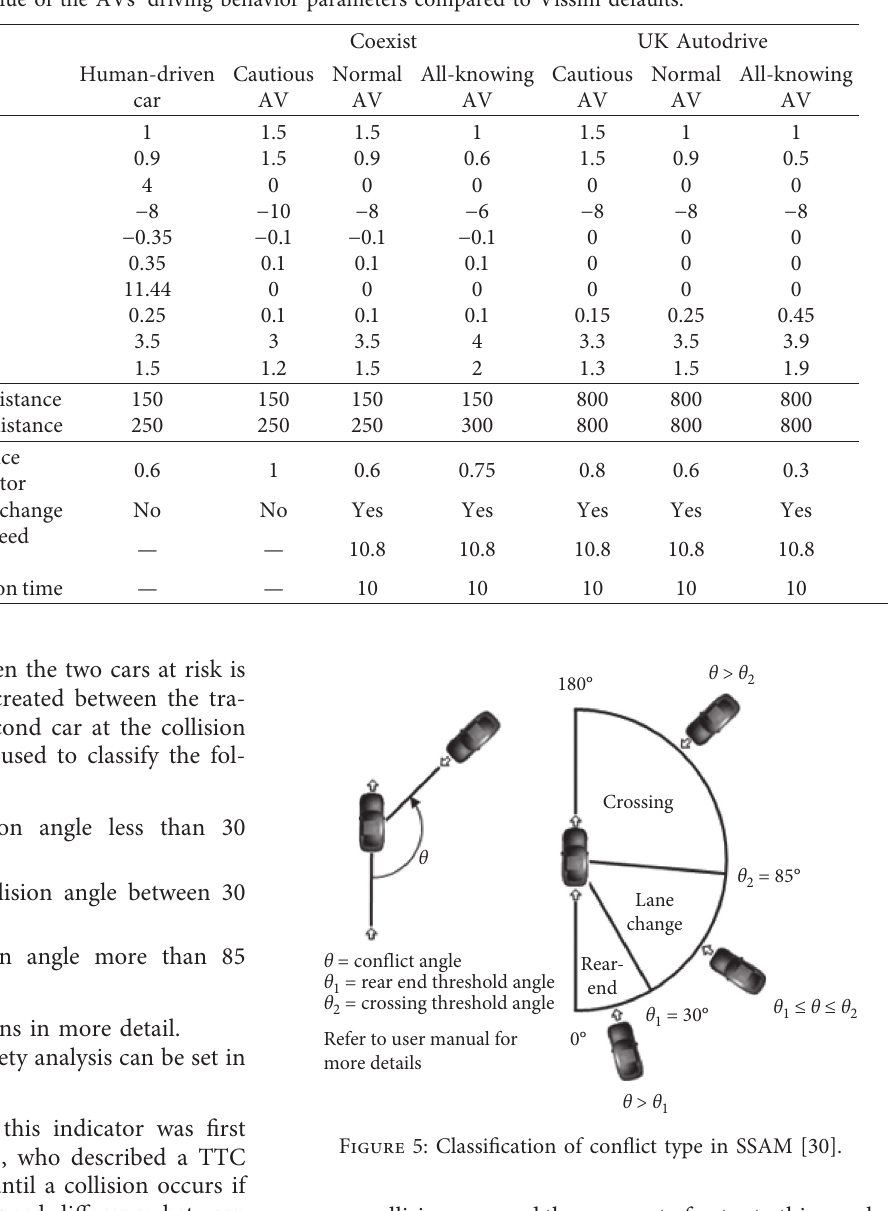
Table 3: The value of the AVs’ driving behavior parameters compared to Vissim defaults.